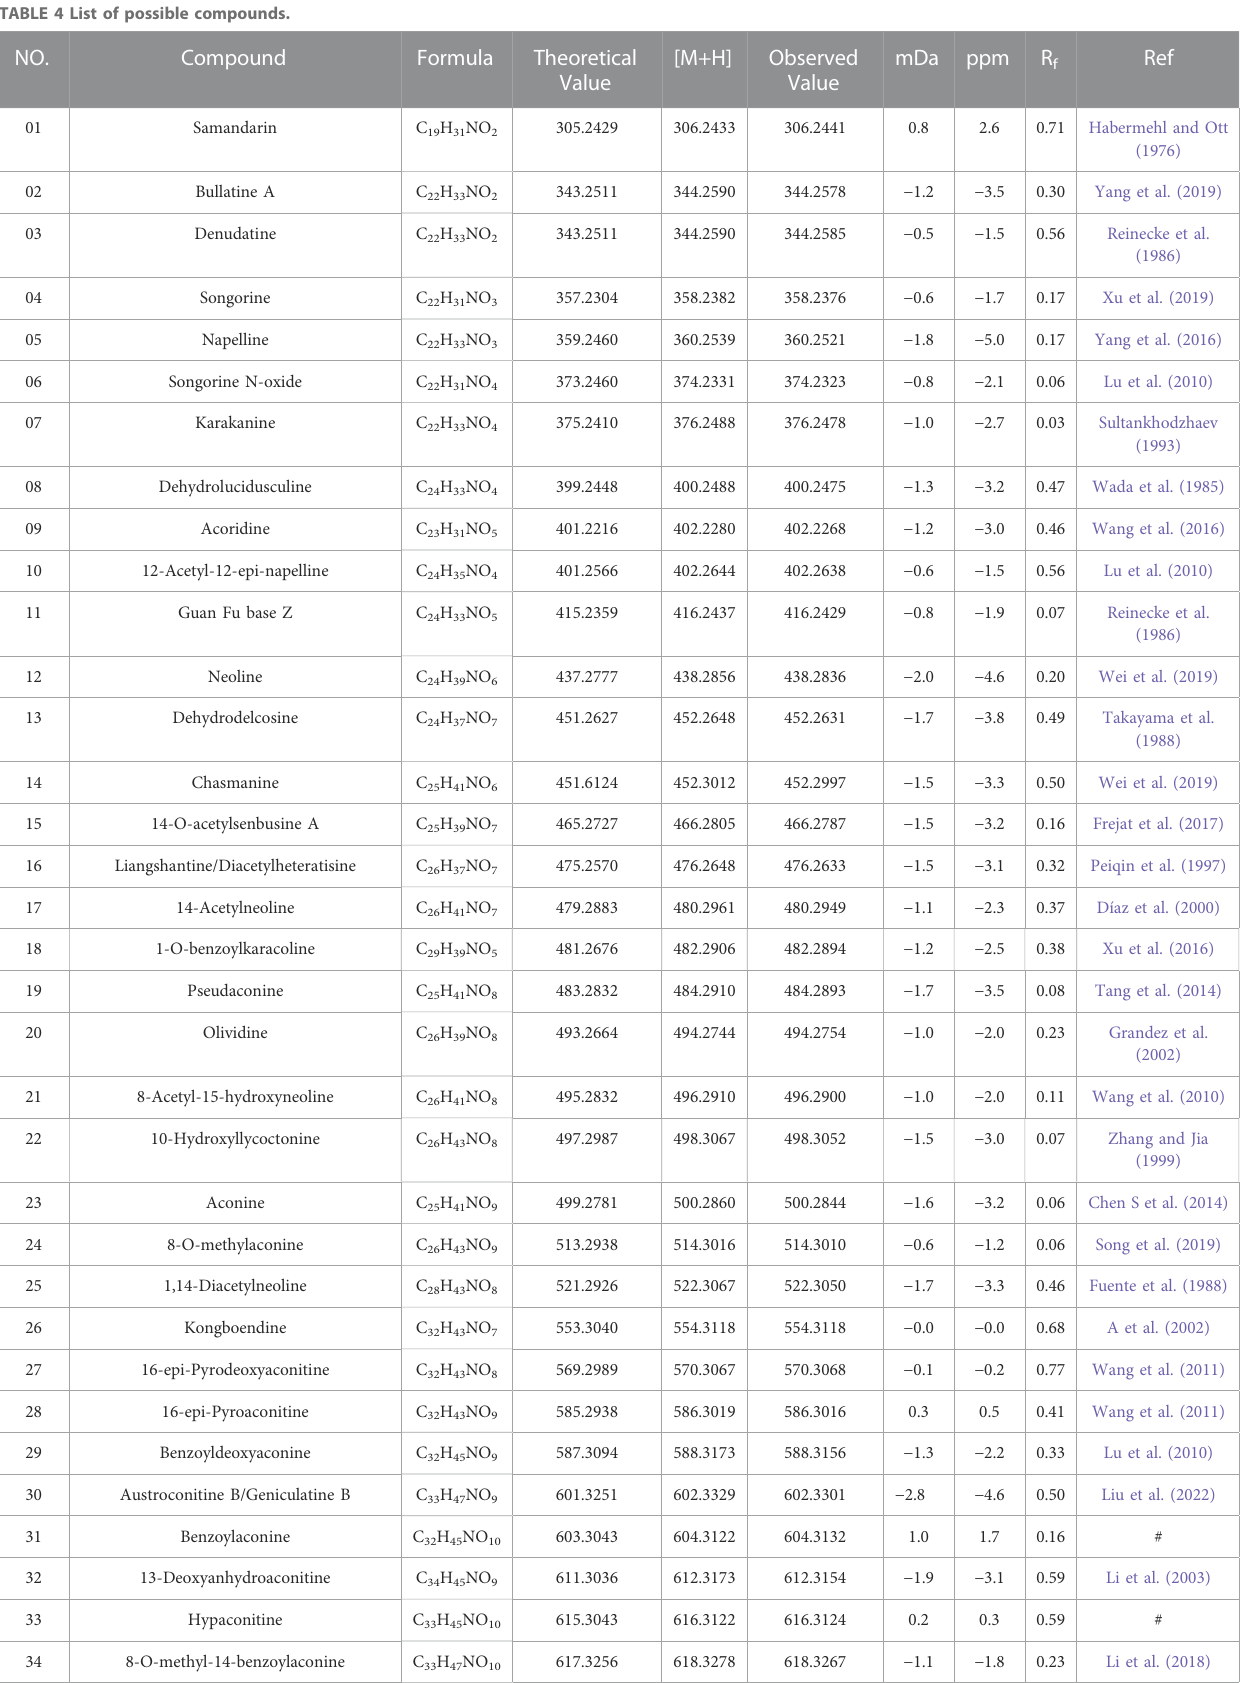
TABLE 4 List of possible